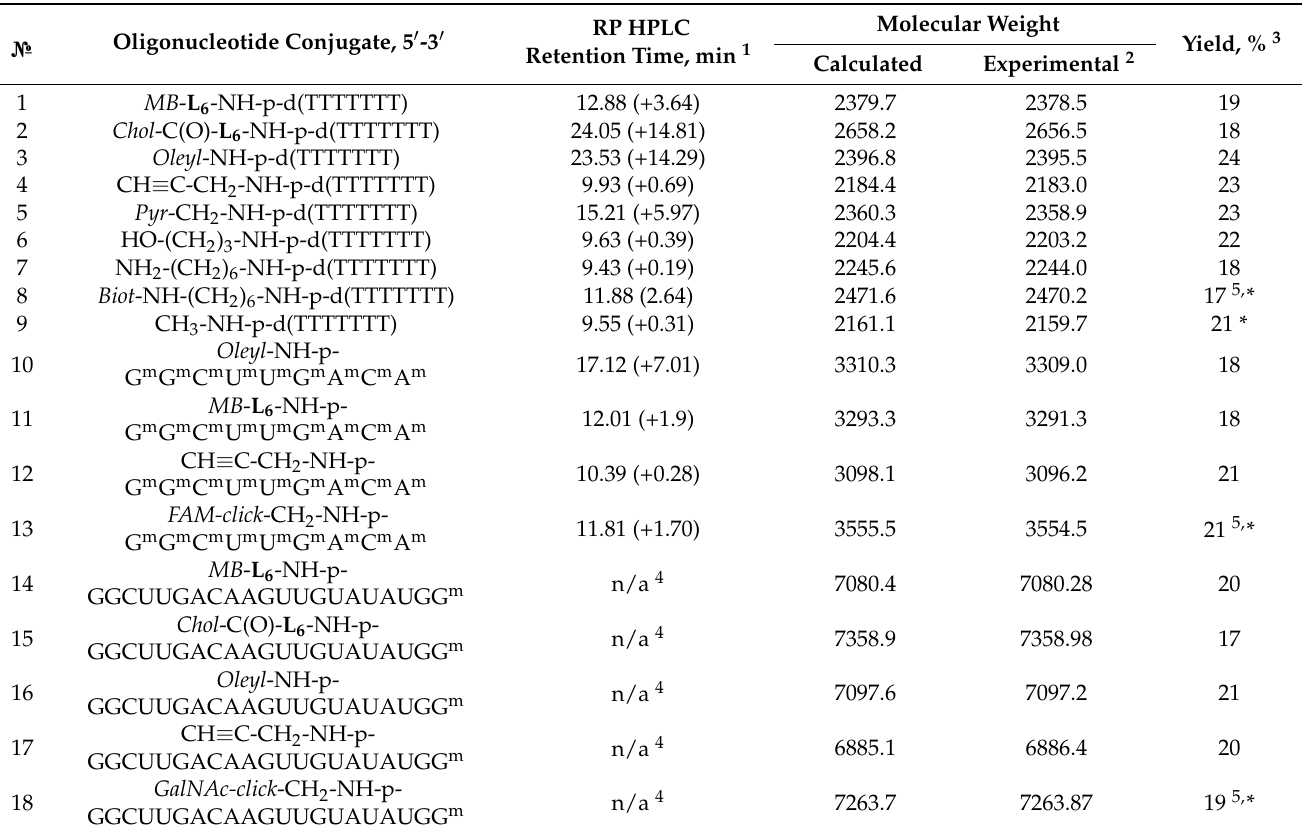
Figure 3. Solid-phase synthesis of 5 ′ -conjugates of oligonucleotides containing an acid-labile P-N- bond (Table 1). Table 1. Synthesized conjugates of oligonucleotides and their characteristics.